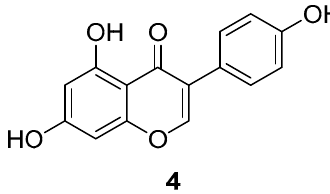
Figure 4. Genistein.